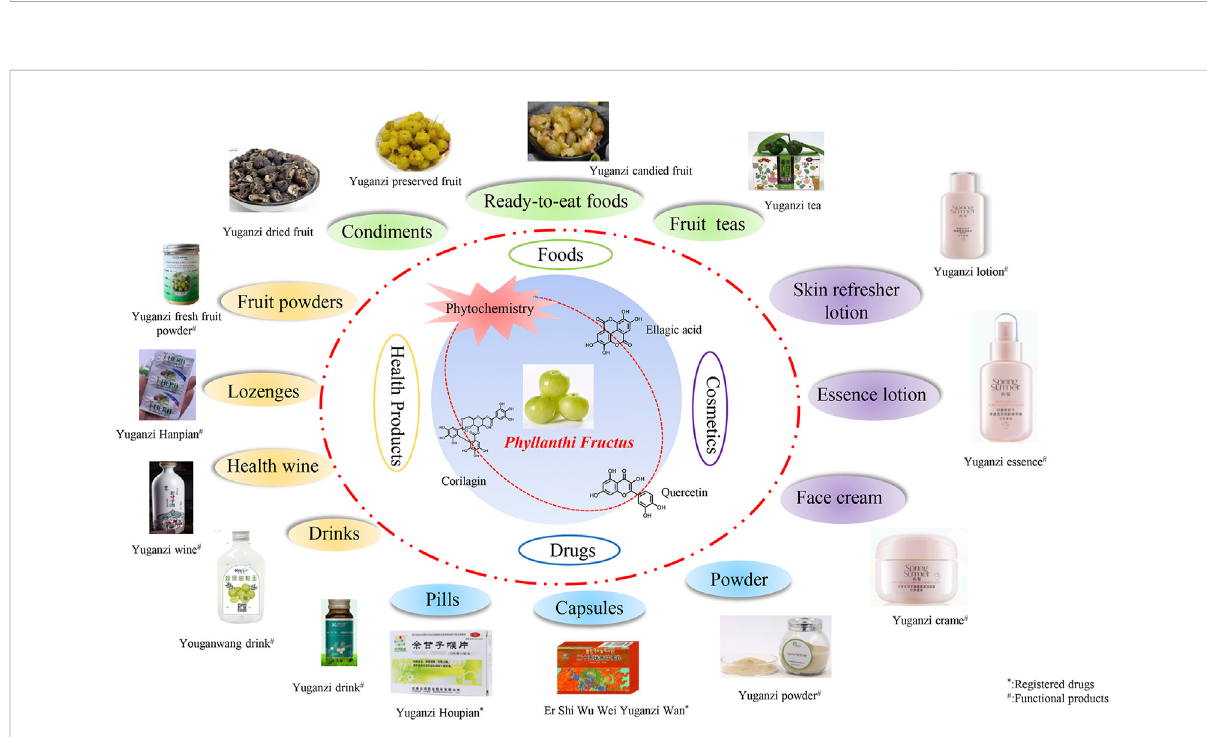
FIGURE 8 Various products using PF as a raw